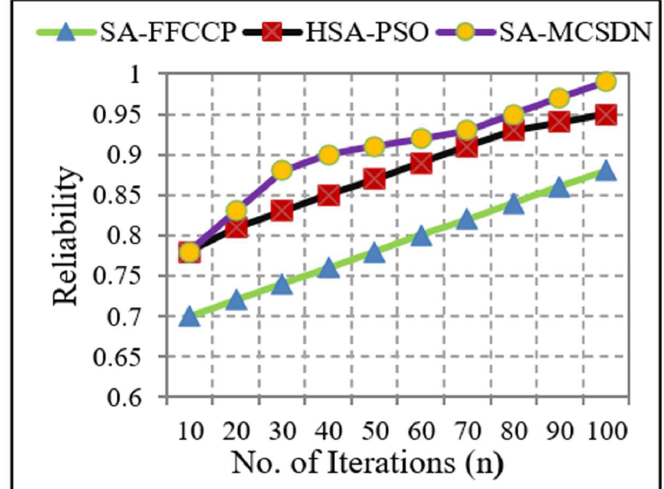
Figure 10. Comparison of reliability.